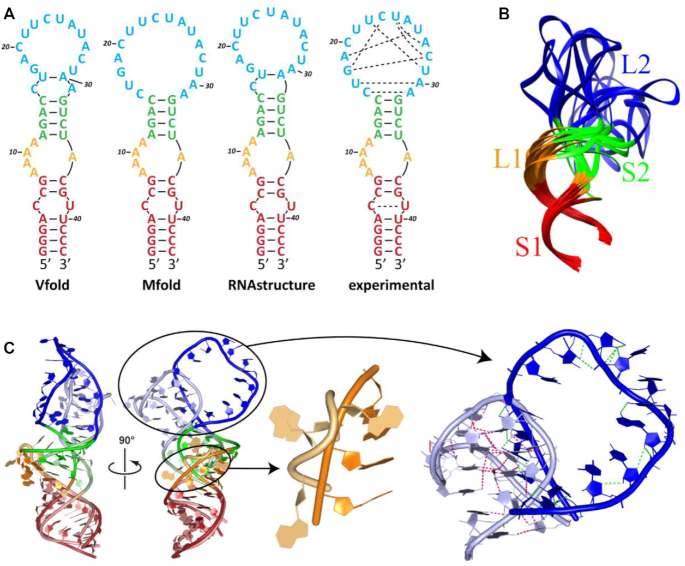
Comparison of in silico models of free A9g with the experimentally determined structure of the PSMA-bound aptamer. (A) Secondary structure predictions of the free A9g aptamer by the free energy-based programs Vfold, Mfold and RNAstructure, compared to the experimentally determined structure reported here. Predicted structures are colored red, orange, green and blue for S1 stem, L1 loop, S2 stem and L2 loop, respectively. Canonical and noncanonical base pairing is shown in full and dashed lines, respectively. (B) The top 10 predicted centroid structures for the A9g free state. The noncanonical base pairing in the PSMA-interacting L2 loop is disrupted in solution and the loop is quite flexible. (C) 3D structures of the bound (experimental) and free (in silico modeled) A9g. Superposition of the top predicted structure of the free A9g aptamer (dark) and the experimental 3D structure (light). While the overall spatial organization is conserved, there are noticeable structural differences in L1 and L2 loops interacting with PSMA. In the absence of intermolecular RNA–protein interactions, the four unpaired adenines A8–A11 of the L1 loop preferably flip in to form energetically more favorable stacking interactions. A noticeable rearrangement of intramolecular polar interactions within the L2 loop occurs upon A9g binding to PSMA as compared to the free aptamer (magenta and green dashed lines, respectively).